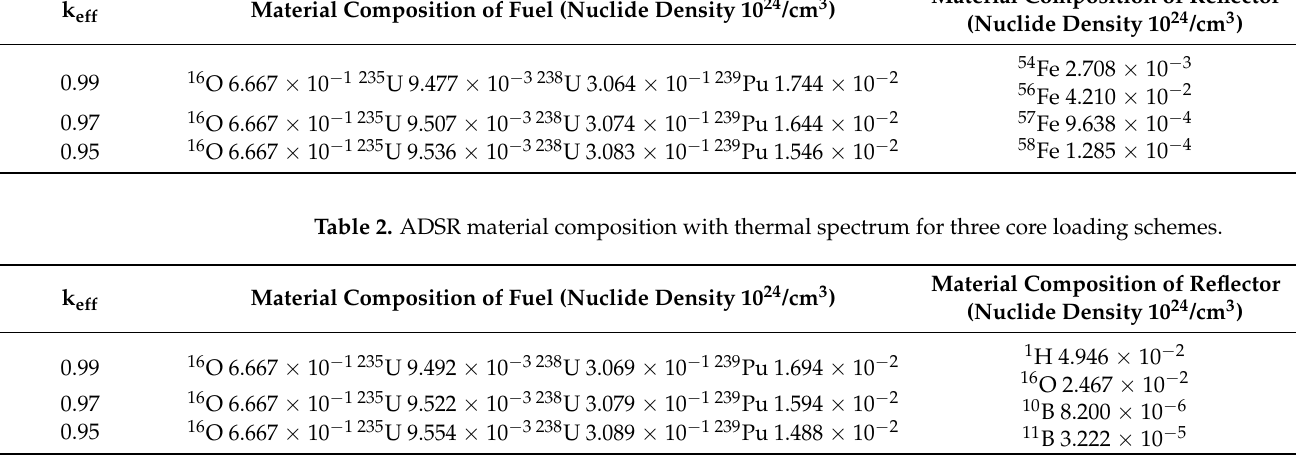
Table 1. ADSR material composition with fast spectrum for three core loading schemes. k eff Material Composition of Fuel (Nuclide Density 10 24 /cm 3 )